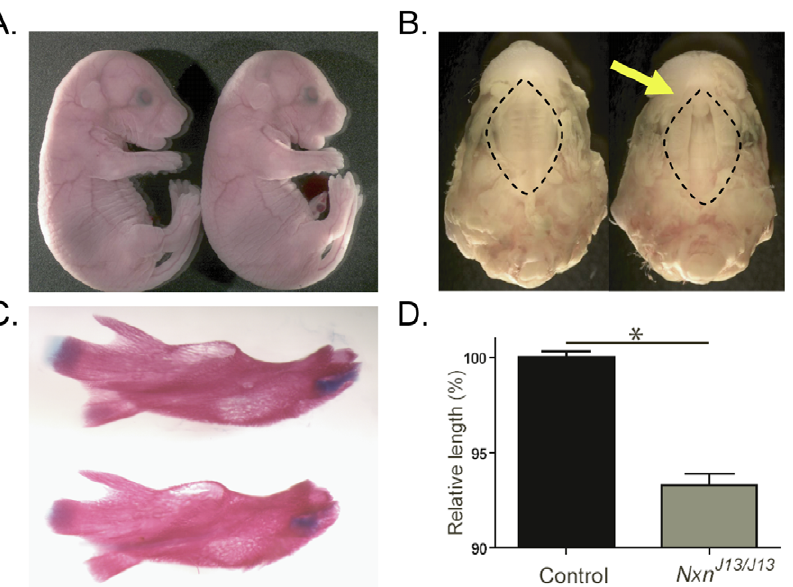
Figure 4. Nxn J13/J13 mutants have cleft palates and small mandibles. Homozygous Nxn J13/J13 embryos were compared to Nxn J13 + / + Inv control littermates. (A) Gross morphology at E18.5. Nxn J13/J13 mutants (right) have a shortened snout compared to control littermates (left). (B) The palate (inside the dotted lines) was examined at E18.5, and a cleft palate (yellow arrow) occurred in Nxn J13/J13 embryos (right) but not in control littermates (left). (C) Skeletal preparations were carried out at E18.5. The mandible is shorter in length in Nxn J13/J13 embryos (bottom) than in control littermates (top). (D) The mean and standard error are plotted to show the difference in mandible length. Mutant mandibles are significantly (p , 0.001) shorter than controls (n=10 mandibles per genotype).